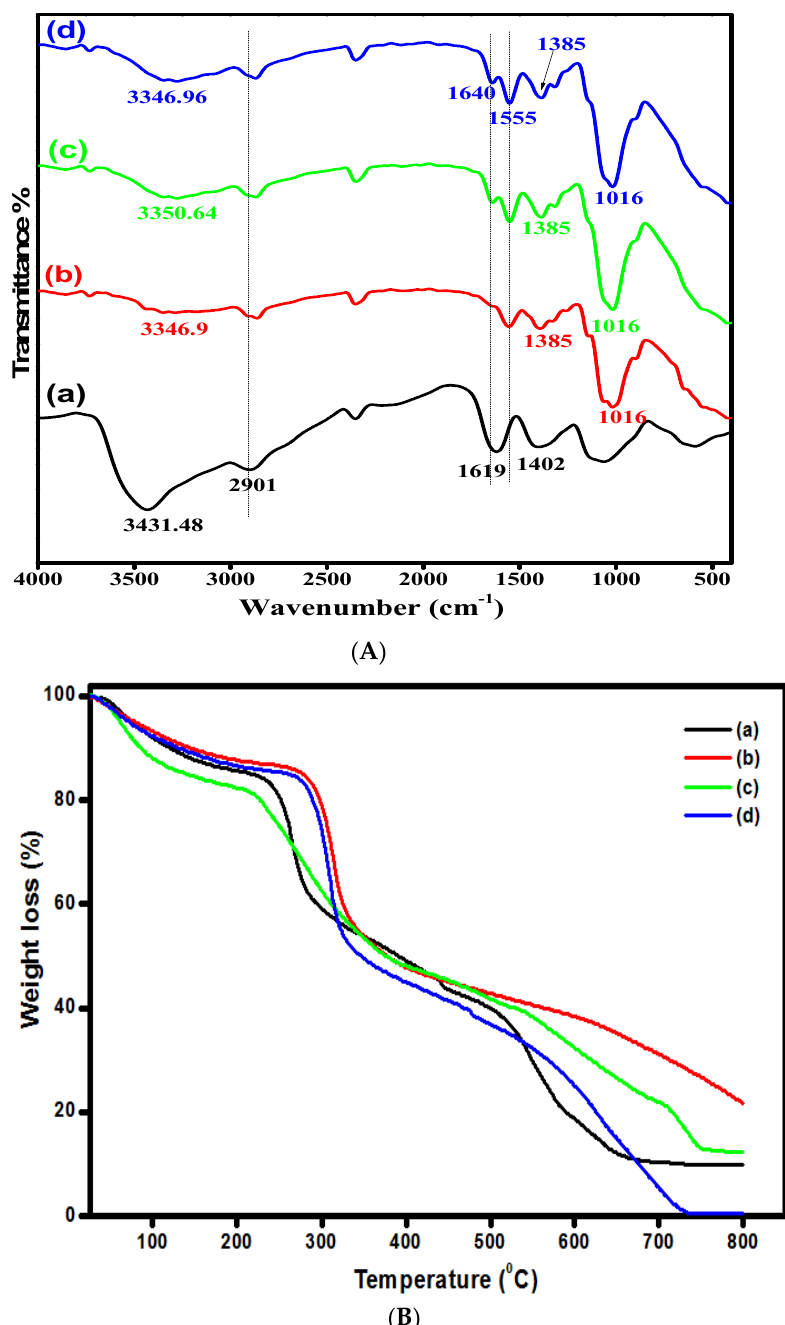
Figure 2. ( A ) FTIR spectra and ( B ) TGA thermograms of (a) aminochitosan (b) quaternized aminochitosan 1 (c) quaternized aminochitosan 2 and (d) quaternized aminochitosan 3 membranes.